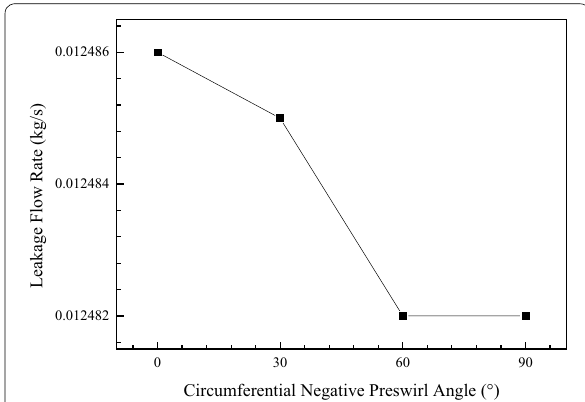
Figure 14 Leakage flow rate versus circumferential negative pre-swirl angle